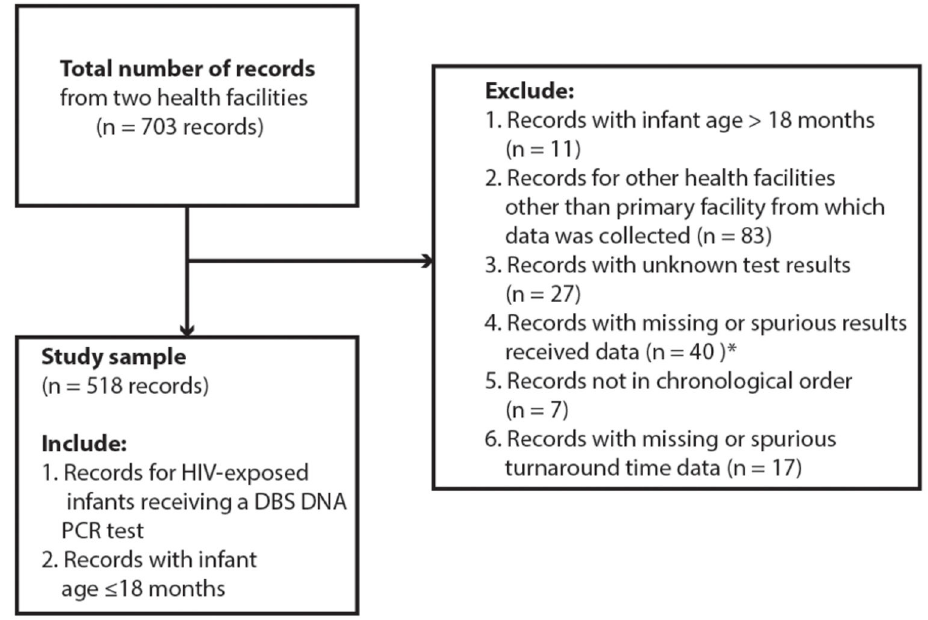
Figure 1. Record selection flowchart. * 32/40 records indicated that result receipt data was missing; 8/40 records indicated that the result was not received but corresponding clinic records showed that the infant was enrolled in treatment.